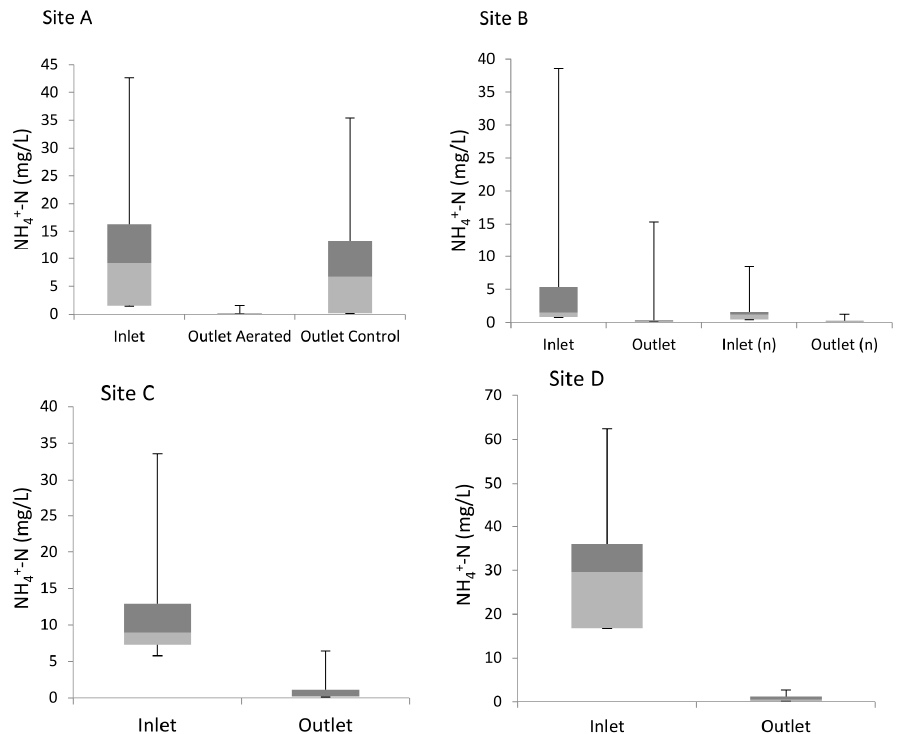
Figure 3. Box and whisker plot of NH 4+ ‐ N, concentrations at the inlet and the outlet of the control and aerated beds. ( n = Site B data excluding the upstream process failure). The box represents the interquartile range; the line indicates the mean and the whiskers the 25th and 75th percentiles.